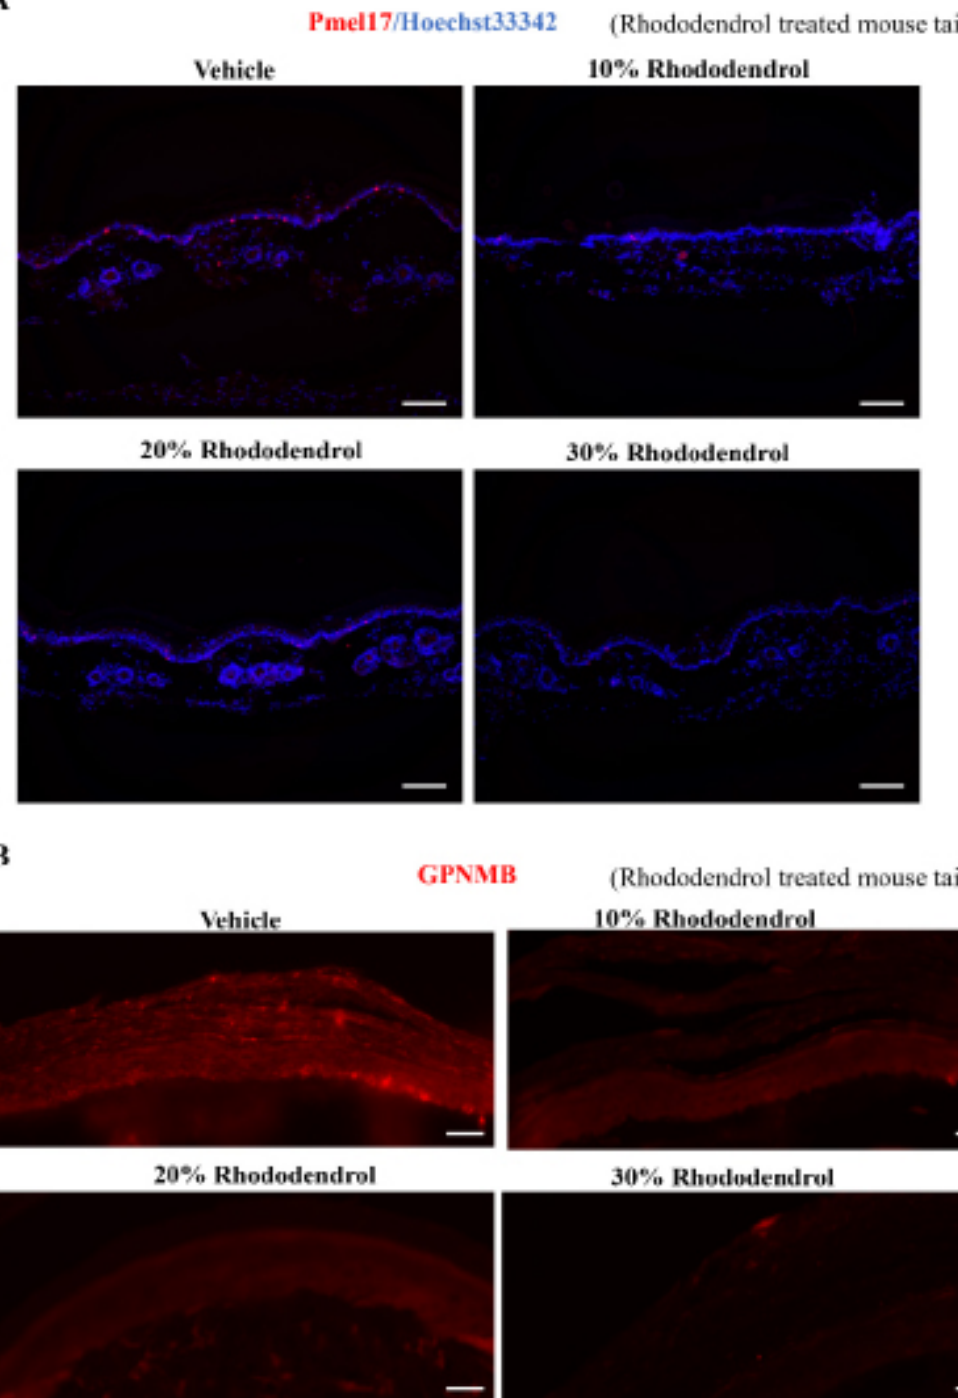
Figure 6. Rhododendrol application on mouse tail skin downregulates GPNMB. Topical rhododendrol from 10% to 30% v/w in ethanol were applied to the tail of 7 weeks old C57BL6/J mice. After 20 days of topical application, tail skin was collected, and skin sections were stained with anti-Pmel17 (A) and anti-GPNMB (B) antibodies. Scale bar: 100